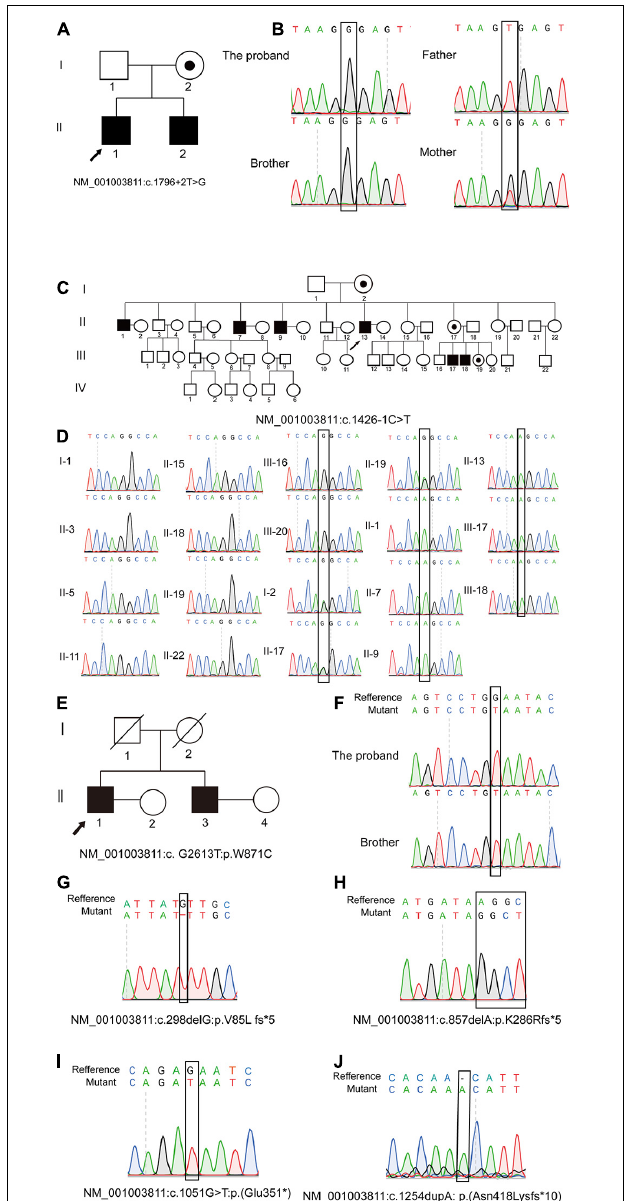
FIGURE 1 | Pedigree of families and Sanger sequencing validation. Pedigrees of three families with X-linked congenital azoospermia. The arrowheads indicate the probands, Squares indicate males, circles indicate females, slashed symbols indicate deceased, black symbols indicate affected individuals, unfilled symbols indicate unaffected individuals, and unaffected, obligate carriers are represented by a dotted circle. (A,B) Pedigree of family P5648: The two affected brothers underwent whole-exome sequencing (WES) and their mother is obligate unaffected carrier. (C,D) Pedigree of family P6825: The proband II-1 underwent WES, while other family members underwent Sanger sequencing. Four brothers and two nephews (II-1; II-7; II-9; II-13; III-17; III-18; III-1; III-2) are affected individuals. The sister of the proband, niece, and mother are obligate unaffected carriers (I-2; II-17; III-19). Other family members do not carry the mutation (I-1, II-3, II-5, II-11, II-15, II-18, II-19; II-22; III-16; III-20). (E,F) Pedigree of family P7583: the proband and his affected twin brother underwent WES while their parents are deceased. (G–J) Four affected individuals underwent WES and validated by